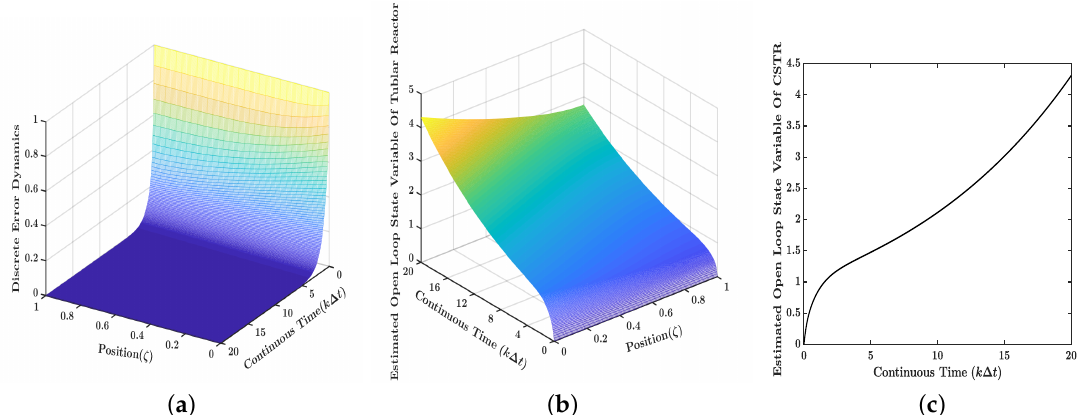
Figure 6. ( a ) Evolution of the discrete error dynamics with the value L c = 5 for observer gain; ( b ) The estimated state profile evolution ( x I ( ζ , k ) ) through dispersive tubular reactor constructed on the basis of discrete-time coupled ODE-PDE system in an open-loop condition; ( c ) Dynamics reconstruction of the scalar variable within the CSTR in an open-loop